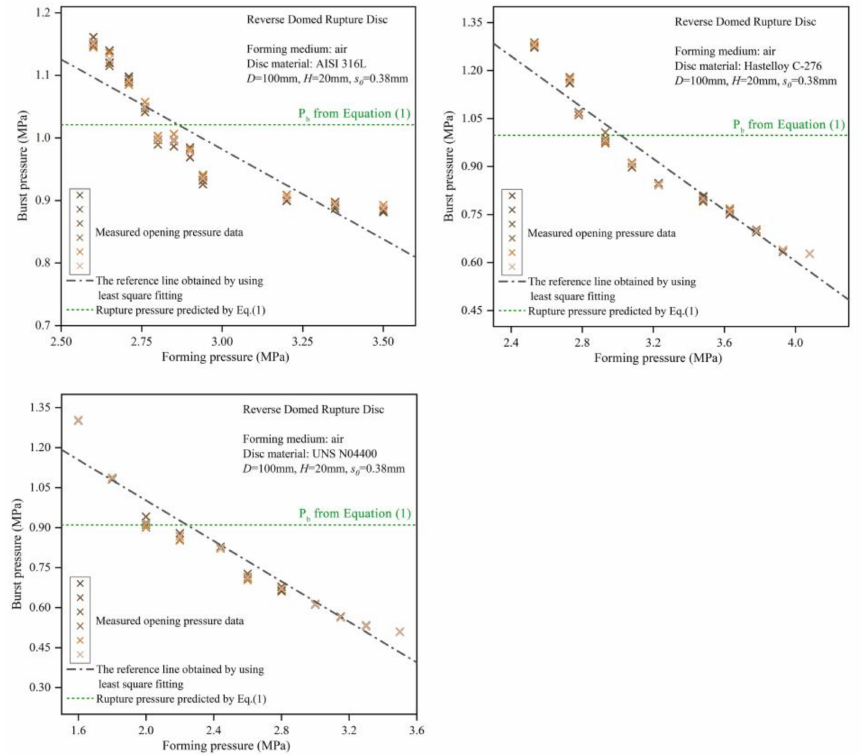
Figure 13. For the pneumatic forming method, the relationship between the burst pressure and the forming pressure of rupture discs with different materials with a diameter of 100